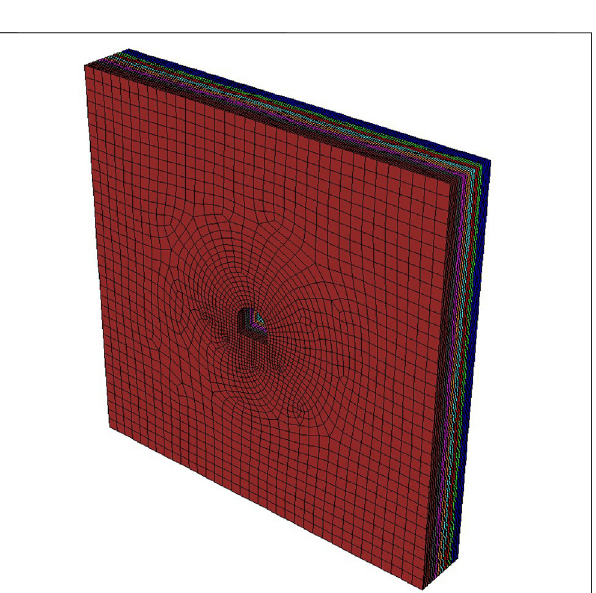
FIGURE 3 | Numerical